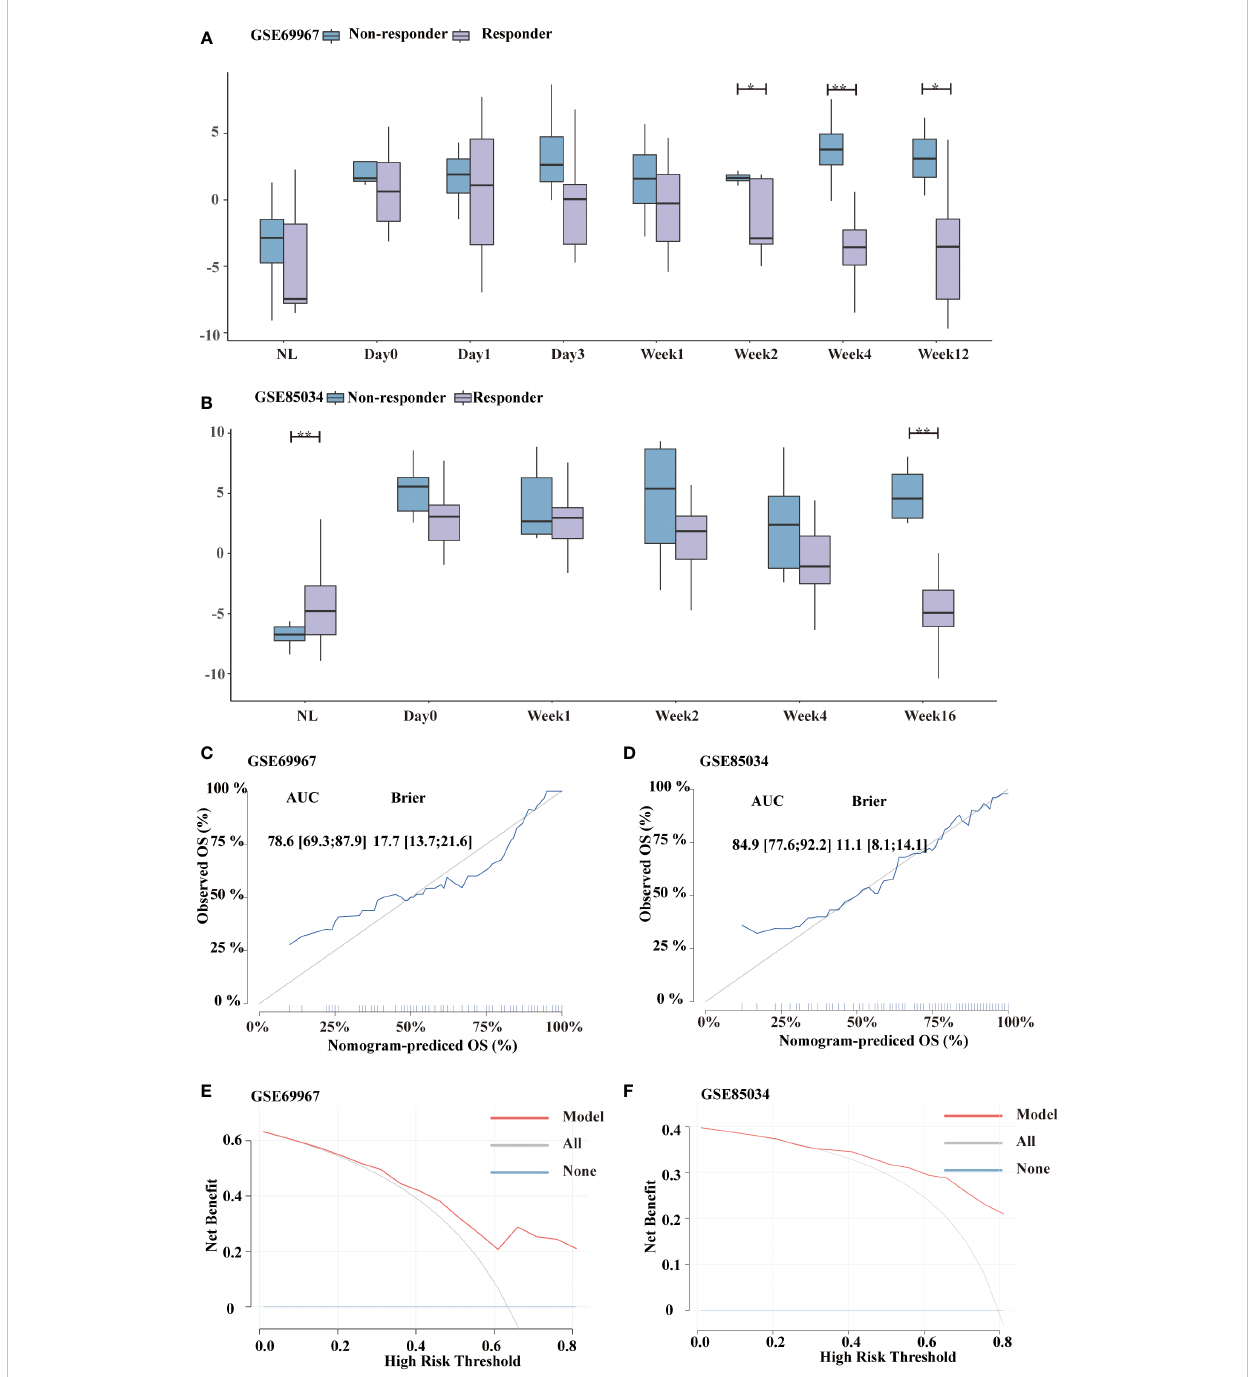
FIGURE 7 Distinguishment of responders and non-responders using glycolysis score. (A, B) Boxplot showing the distribution of glycolysis score between responders and non-responders in GSE69967 (patients treated with tofacitinib) and GSE85034 (patients treated with methotrexate or adalimumab) cohort, respectively. (C, D) Calibration curve of the glycolysis signature in GSE69967 and GSE85034 cohort. (E, F) Decision Curve Analysis of the glycolysis signature in GSE69967 and GSE85034 cohort. *P<0.05,